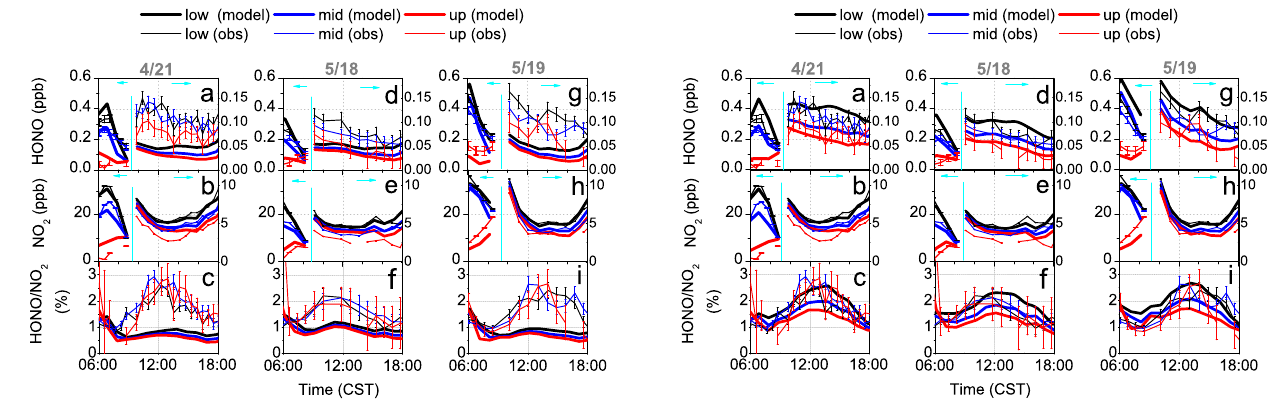
Fig. 6. Comparisons between observations and model results with Fig. 7. Comparisons between observations and model results with a photolytic HONO gas-phase formation from NO ∗ + H 2 O (Li et al., photolytic HONO source at the ground and on aerosol. Shown are 2 2008) only. Shown here are daytime HONO (a, d, g) , NO 2 (b, e, h) , daytime HONO (a, d, g) , NO 2 (b, e, h) , and HONO/NO 2 ratios (c, and HONO/NO 2 ratios (c, f, i) in the lower (black), middle (blue), f, i) in the lower (black), middle (blue), and upper (red) height alti- and upper (red) height altitudes on 21 April (left panel), 18 May tudes on 21 April (left panel), 18 May (middle panel), and 19 May (middle panel), and 19 May (right panel). HONO and NO 2 mixing (right panel). HONO and NO 2 mixing ratios after 09:00CST were ratios after 09:00CST were magnified with a different scale on the magnified with a different scale on the right right axis.